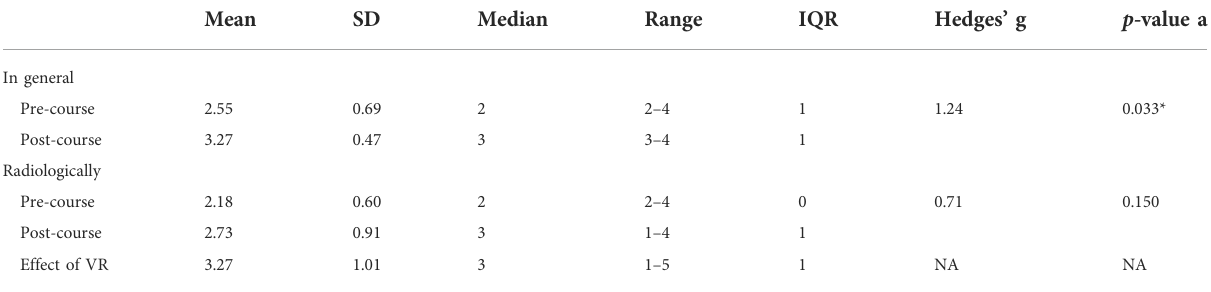
TABLE 3 Scores from the participants self-evaluation of temporal bone anatomy understanding and effect of VR. All values are nominal (SD) on a 5- point Likert scale. Mean SD Median Range IQR Hedges ’ g